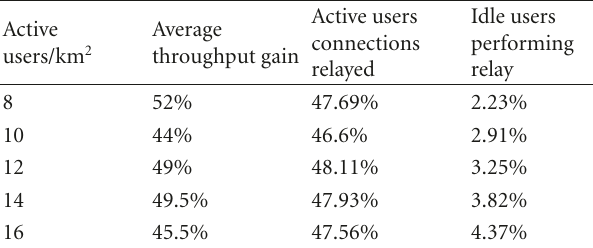
Figure 9: Distribution of the distance between relayed MS and its BS. Table 3: Throughput increase as function of active user